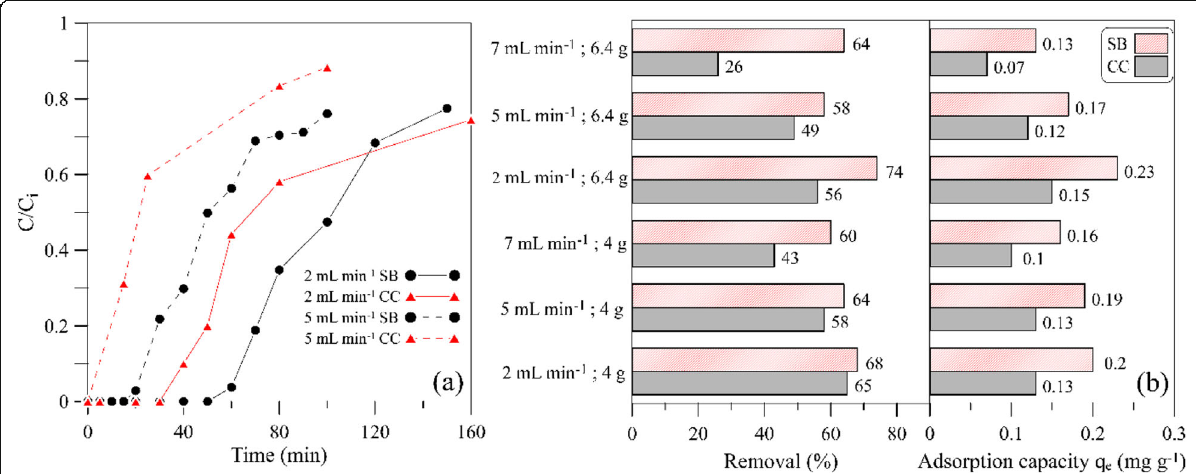
Fig. 5 Breakthrough curves ( a ) and operating parameters ( b ) of the SMX adsorption with SB and CC with an initial concentration of 5 mg L − 1